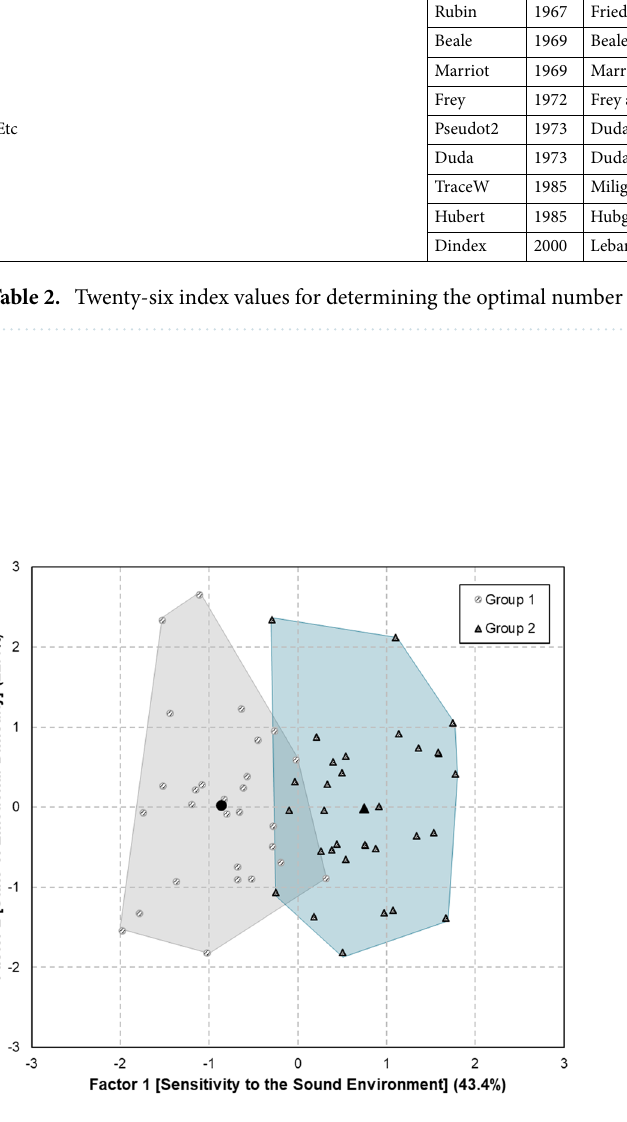
Figure 3. Cluster analysis results based on health conditions. Groups 1 and 2 represent low and high noise- sensitivity,